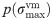
Left: Decrease of the objective function over the number of training iterations, where the first training iteration corresponds to the Kriging surrogate after ninit = 8 model evaluations. 11 model evaluations were used for the surrogate creation. Right: Estimated Kriging-based distribution p(σmaxvm) along with a Monte Carlo reference. All densities were calculated using kernel density estimation with Gaussian kernels based on 10, 000 samples of the maximum von Mises stress σmaxvm.